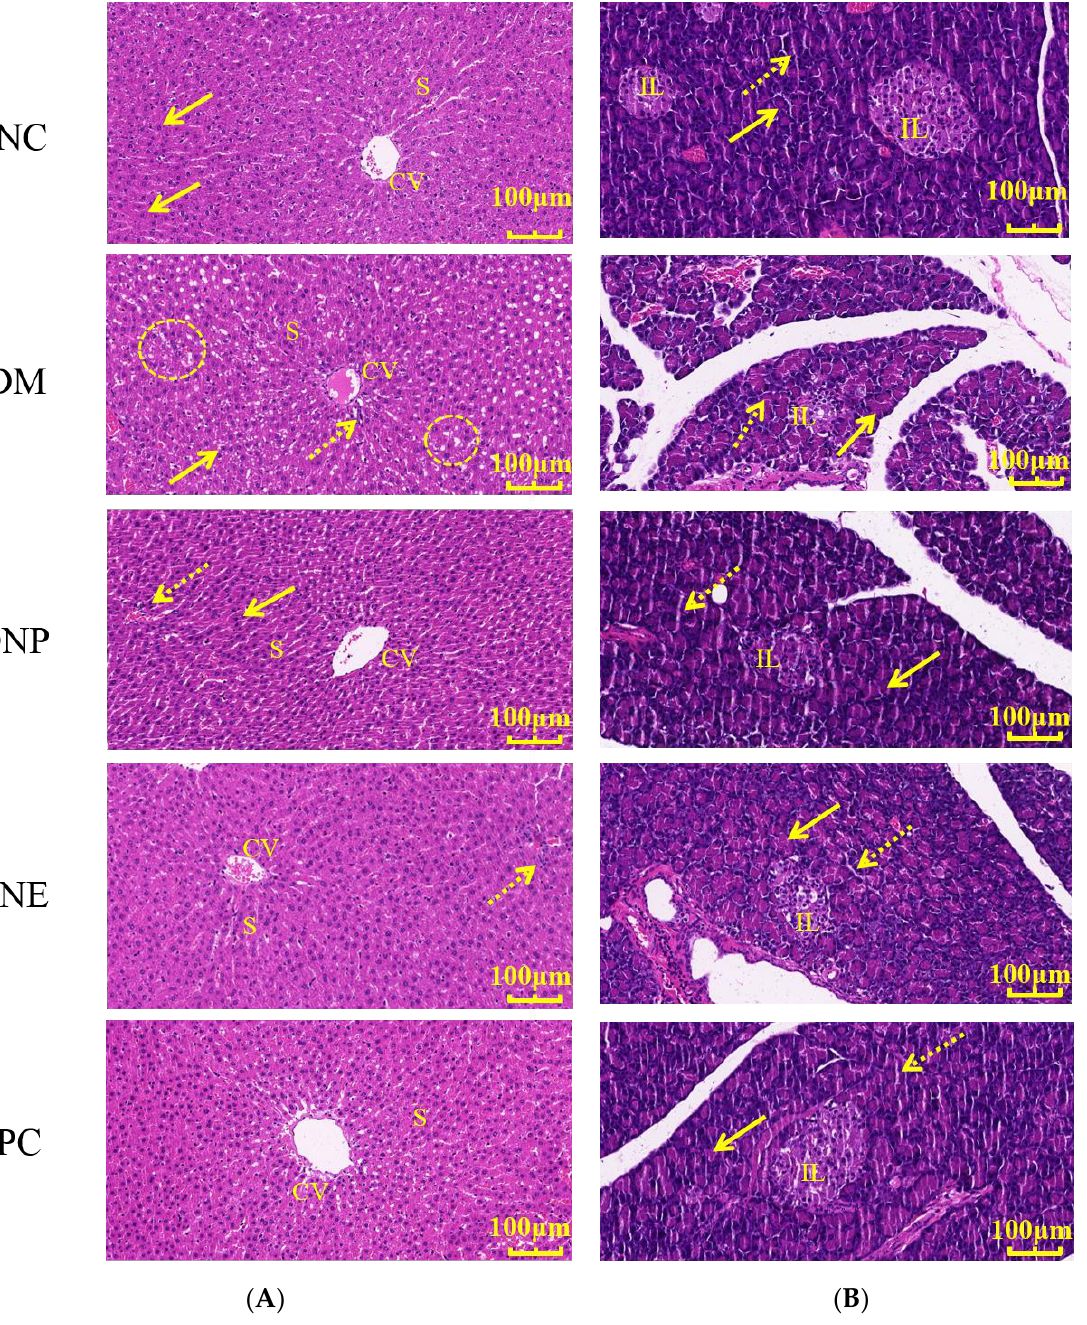
Figure 14. Effects of D. nobile on liver ( A ) and pancreas ( B ) tissues of T2DM rats. Central vein (CV), hepatic sinusoid (s), hepatocytes (arrow), inflammatory cell infiltration (dotted arrow) and accumulation of fatty infiltration (circle) in the liver, islets of Langerhans (IL), acinar structure (arrow) and duct (dotted arrow) in the pancreas.